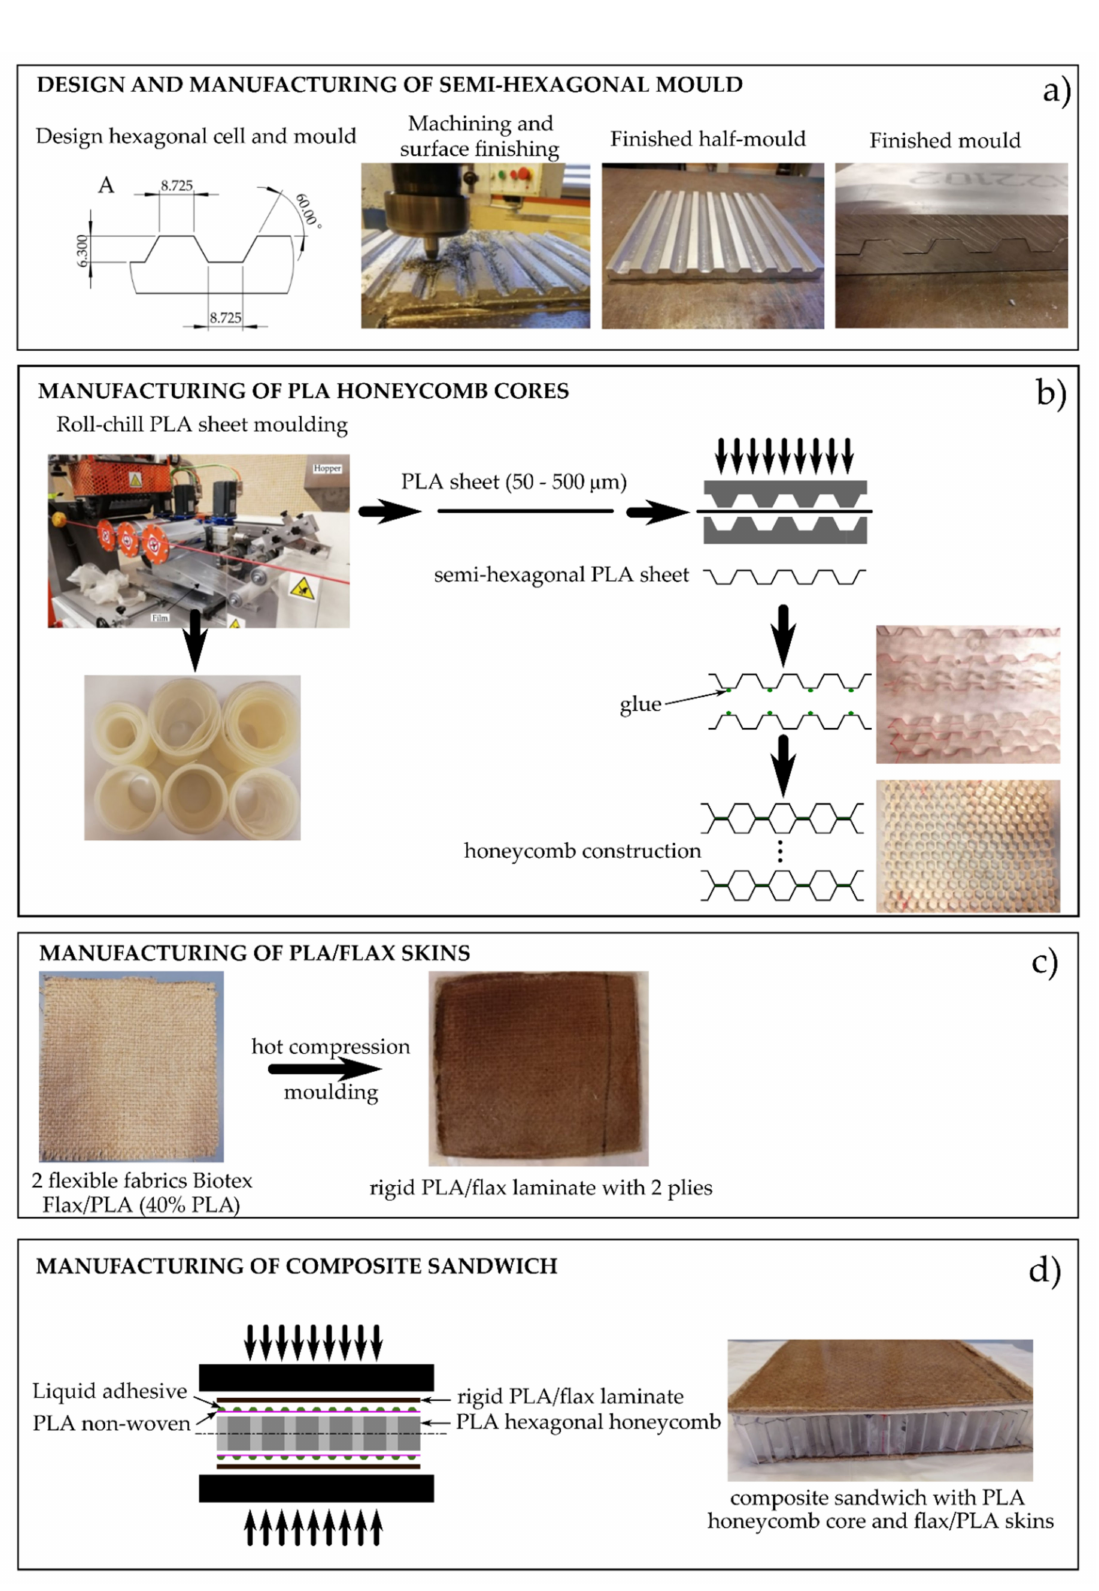
Figure 1. Schematic plot showing the different stages of the manufacturing process of (polylactide) PLA-honeycomb core-based sandwich